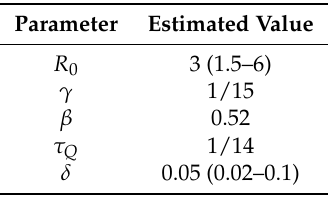
Table 2. Some estimated parameters for COVID-19 (the time unit is days) [29,36,42].